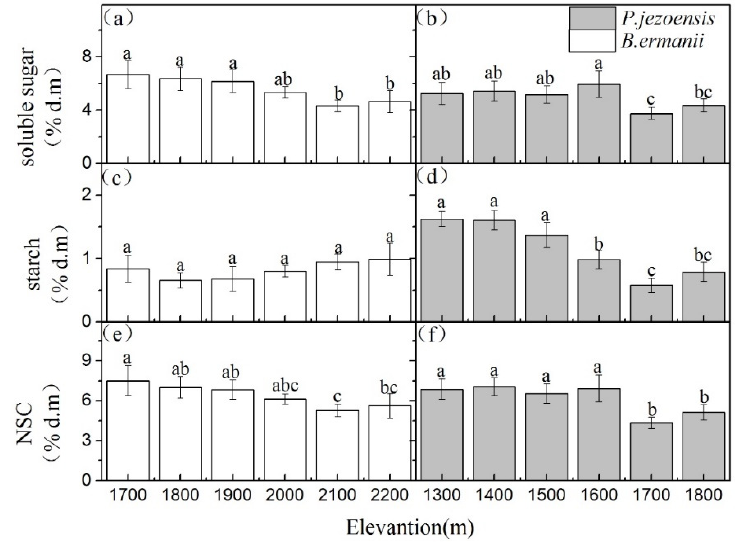
Figure 3. Variation in the concentrations of B. ermanii shoots ( a ) soluble sugar, ( c ) starch and ( e ) NSC as well as P. jezoensis shoots ( b ) soluble sugar, ( d ) starch and ( f ) NSC (mean ± SD; % of dry matter) along with elevational gradients in Changbai Mountain ( n = 5 for each elevational site). Di ff erent letters indicate significant di ff erences ( p < 0.05) among elevations as determined by Tukey’s HSD test single-factor ANOVAs.